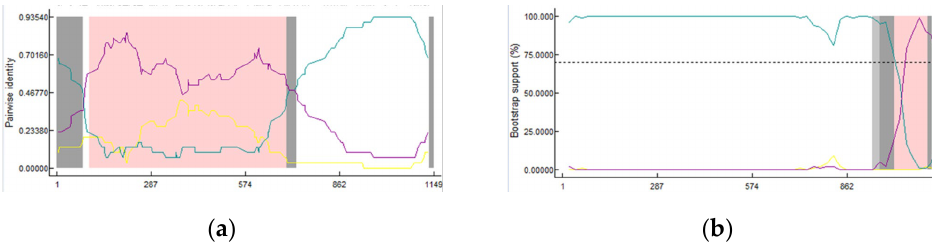
Figure 7. Detection of the potential recombination events in 19 -GXBH- 2 and 18 -GXNN- 6. Detection of potential recombination events in 19 -GXBH- 2: ( a ) RDP software - based screenshots showed the possibility of recombinant events among PEDV G2a PEDV - 7C, PEDV G2c 19 -GXBH- 2 and the G1a strain SC - L; ( b ) detection of potential recombination events in 18 -GXNN- 6: bootscan screenshots showed the possibility of recombinant events among the PEDV G2a strains, CH/SCAZ10 and 18 - GXNN- 6 , as well as the G1a strain CH/S.